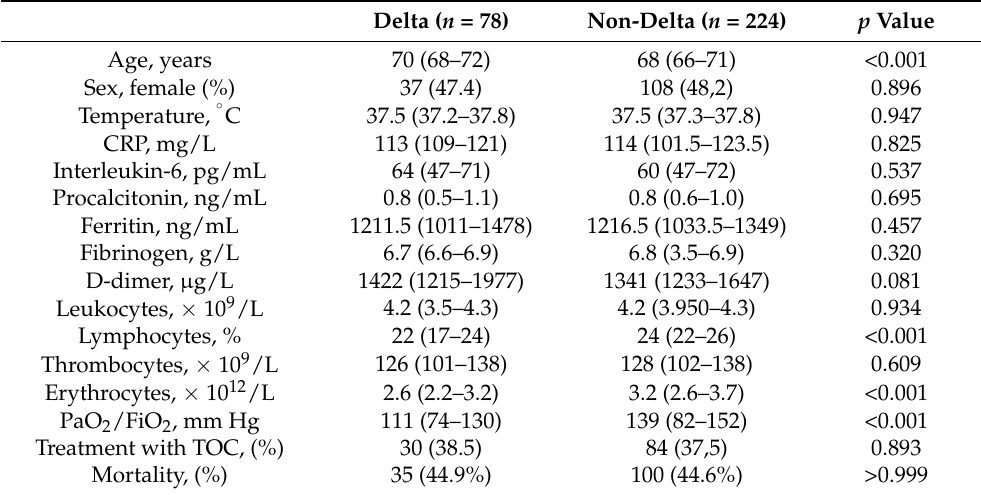
Table 1. Basic demographic and medical data of the groups studied. Median (Q I -Q III ) for continuous variables, numerical values (%) for categorical variables. The Mann–Whitney test was used for comparison between continuous variables, and Fisher’s exact test was used for categorical variables.